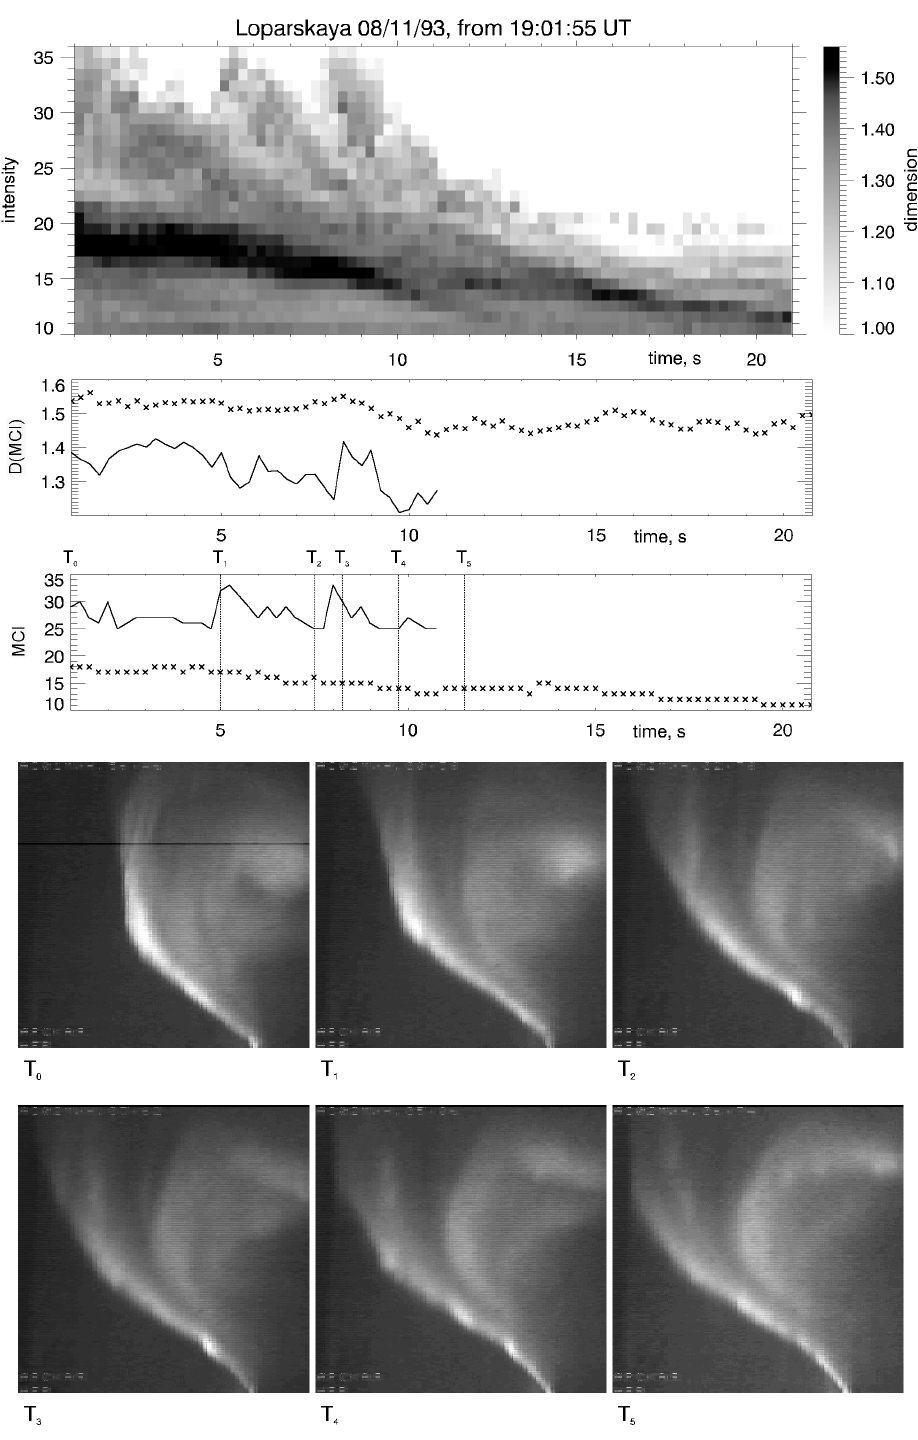
Fig. 12. The same as Fig. 9, but for event 4. Dependences for the local maximum at large intensities and for the intensity associated with the local maximum are marked in panels (b) and (c) by